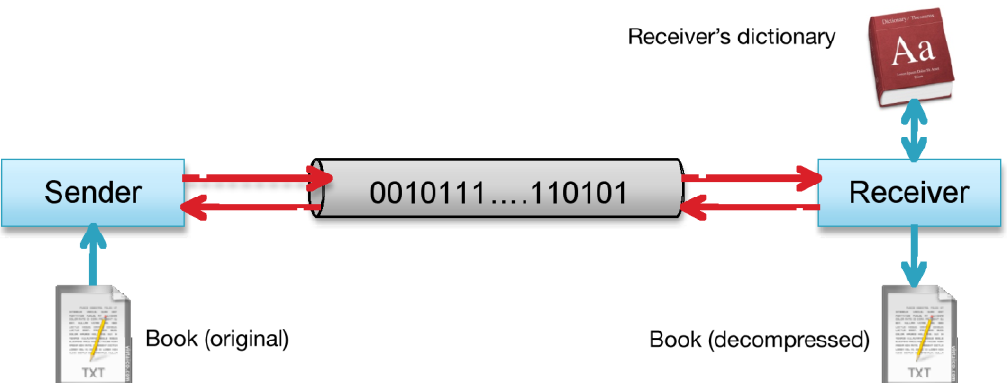
Figure 2. Sender and Receiver communicate a